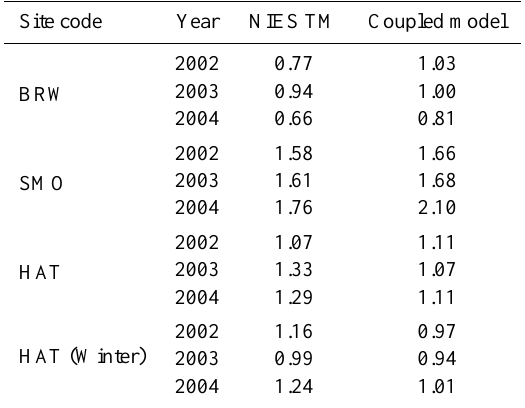
Table 2. Variance ratios between simulated and observed deseason- alized CO 2 concentrations (Winter: from the beginning of January to the end of March, and from the beginning of November to the end of December).